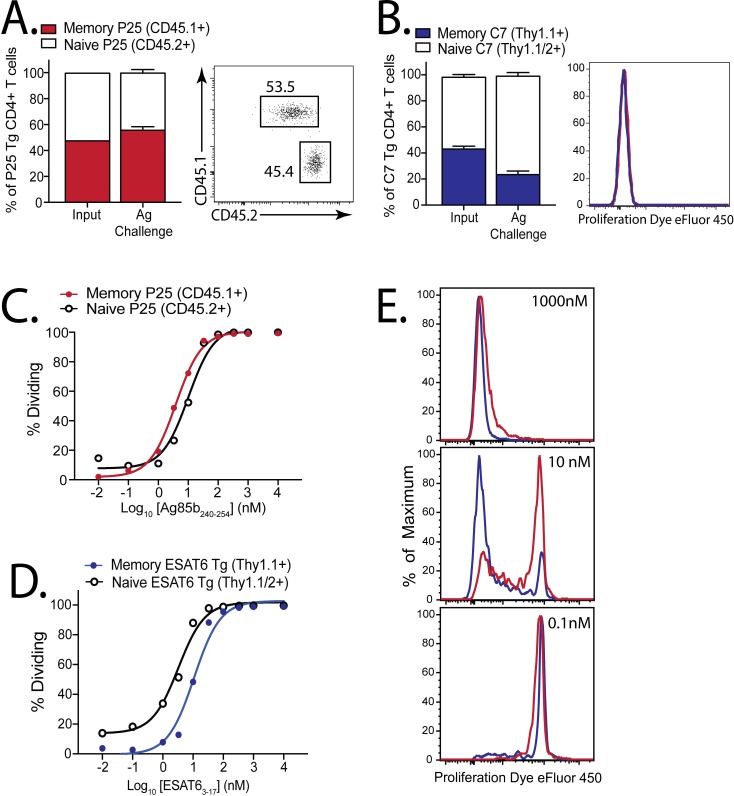
A similar antigen threshold is required to activate memory and naive CD4+ T cells.(a) Ratios of memory (red, CD45.1+) and naive (white, CD45.2+) P25 Tg CD4+ T cells 1 d after 1:1 co-transfer into congenically-marked mice (input ratio), or 3 d after challenge with Ag85b240-254/poly(I:C)/αCD40; representative d3 plot showing ratio (right). (b) Ratios of memory (blue, Thy1.1+/+) and naive (white, Thy1.1+/1.2+) C7 Tg CD4+ T cells 1 d after 1:1 co-transfer into congenically-marked mice (input), or 3 d after challenge with ESAT63-17/poly(I:C)/αCD40; representative d3 plot showing eFluor450 dilution (right). Groups contained 4 mice each. Dose-response curves of proliferating naive or memory (c) P25, or (d) C7 cells, 3–4 d after culture with peptide-coated splenocytes. (e) Representative eFluor450 dilution by memory (red) and naive (blue) C7 cells exposed to different peptide concentrations.